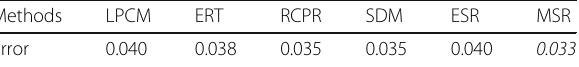
Table 5 Comparisons of different face alignment methods on HELEN